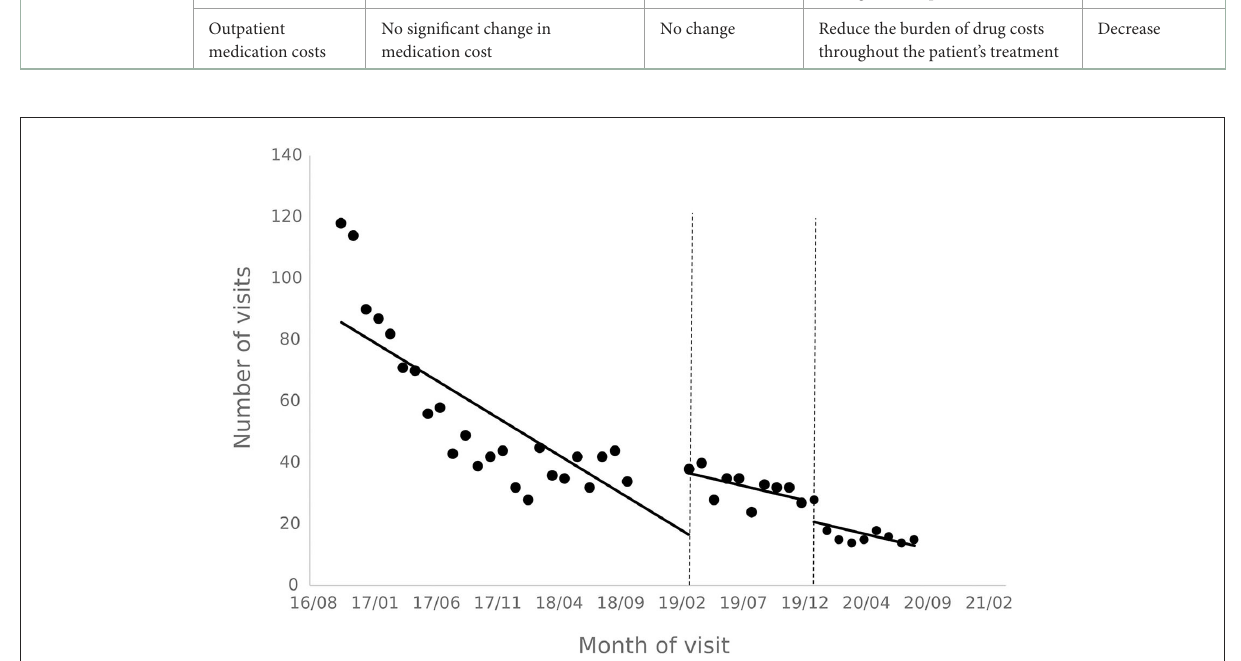
FIGURE1 Outpatient visits to patients with hepatitis C.